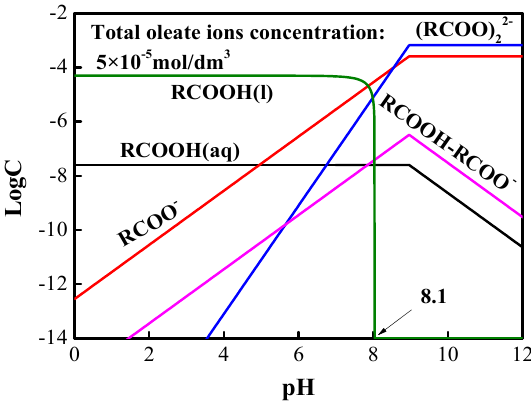
Figure 3. Effect of pH on species distribution diagrams of sodium oleate at concentration of 5.0 × 10 −5 mol/dm 3 .